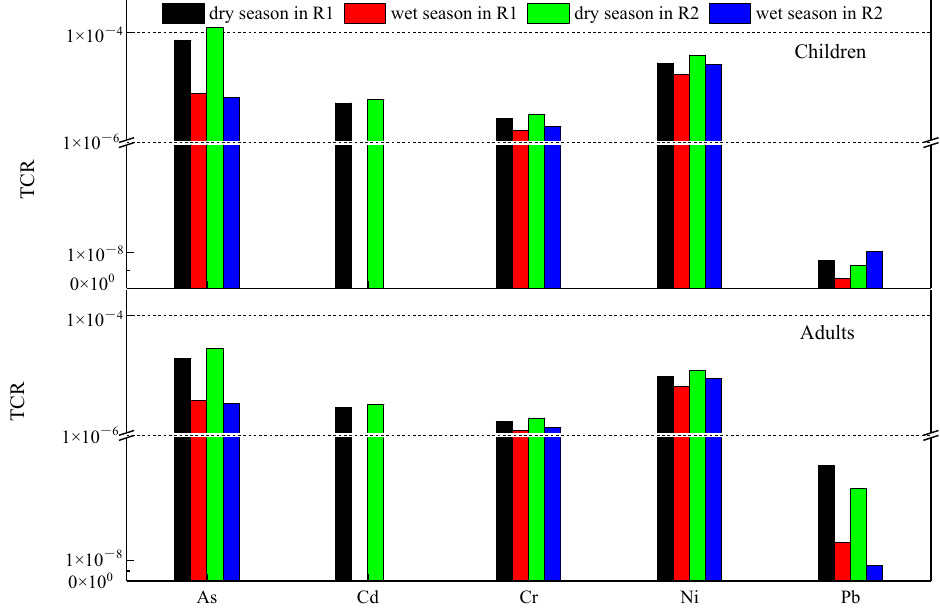
Figure 8. Total carcinogenic risk (TCR) evaluation in the sampling sites for selective aged groups.